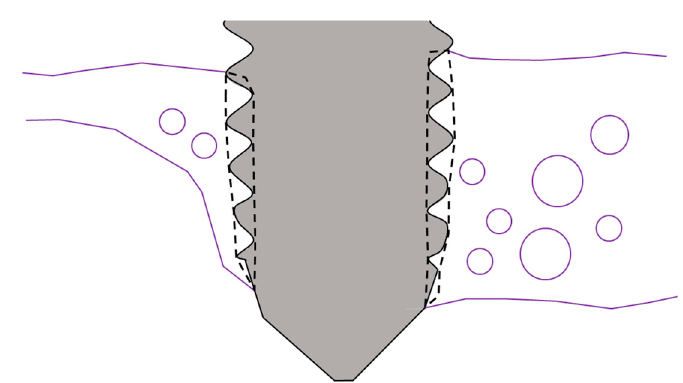
Figure 2. Region of interest (ROI) for the quantitative analysis of bone-to-implant contact (BIC).